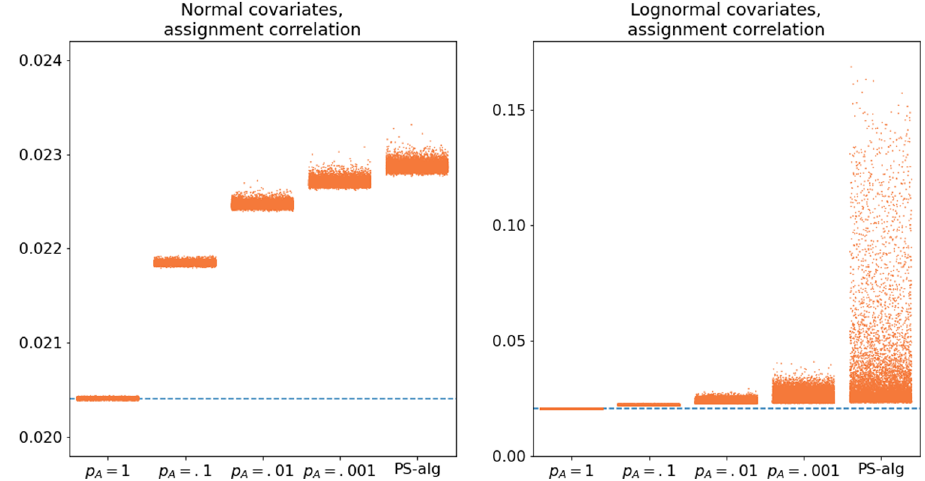
Figure 1: Distribution of assignment correlation for di ff erent designs. Note: The fi gure shows the distribution of the assignment correlation for di ff erent designs on normal ( left graph ) and lognormal ( right graph ) covariates with the dashed horizontal line indicating the assignment correlation for complete randomization. N 50 = and for each sample, the assignment correlations are approximated with 10,000 assignment vectors ( including mirrors ) . A total of 10,000 random samples are drawn. Note that the scale on the y - axis is di ff erent for each